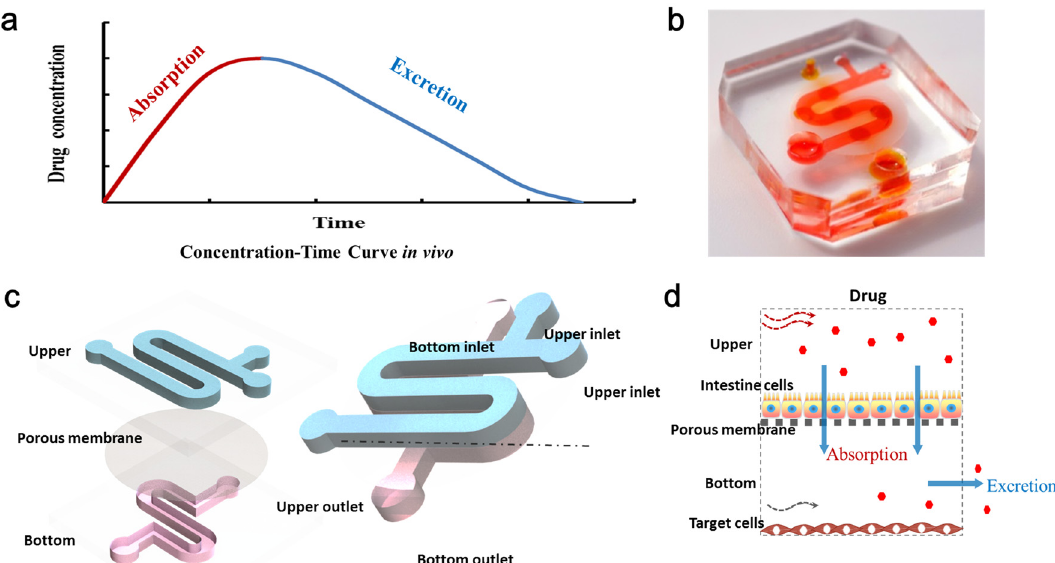
Figure 1. Schematic diagram of the multilayered microfluidic chip for modeling pharmacokinetic (PK) profiles of drug administration. ( a ) The concentration-time curve in vivo. ( b ) The actual image of the multilayered chip. ( c ) The configuration of the chip device. The device is composed of three layers, including the S-shaped upper channel loading with intestine cells, porous membrane, and bottom channel loading with targeted cells. ( d ) Schematic view of the PK process of absorption and excretion on cells with drug exposure in the device.